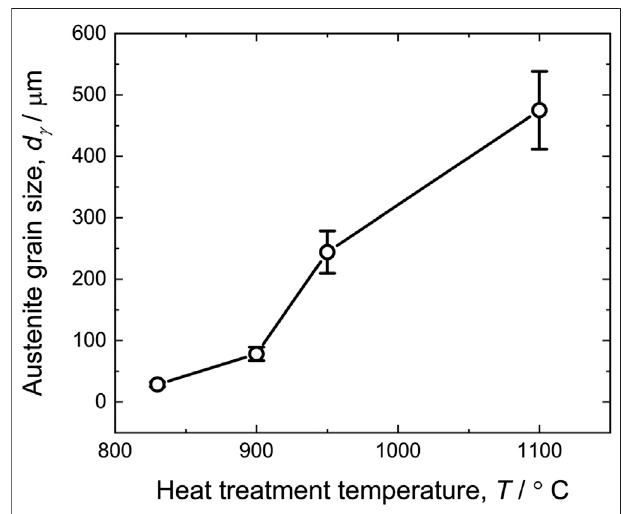
FIGURE 3 | Austenite grain sizes in the specimens simply austenitized and water-quenched, plotted as a function of the austenitizing temperatures.